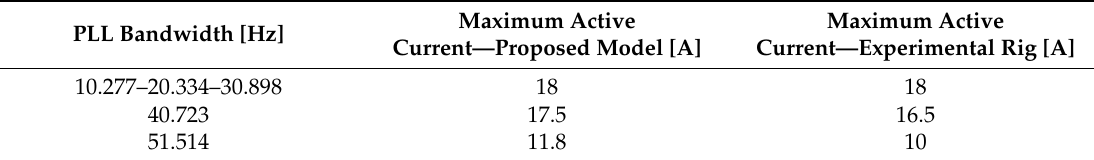
Table 5. Comparison between proposed model and experimental system for SCR =